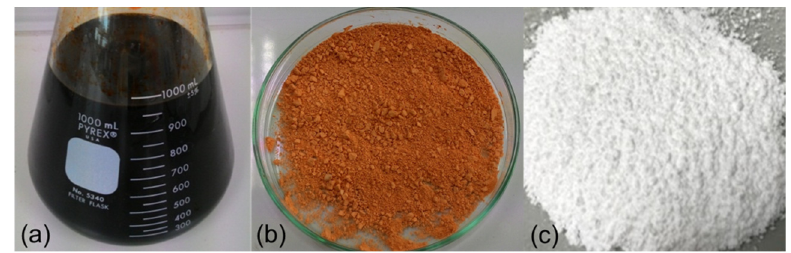
Figure 1. Pictures of; ( a ) CO; ( b ) SiCO; ( c ) DB/ZnSt .